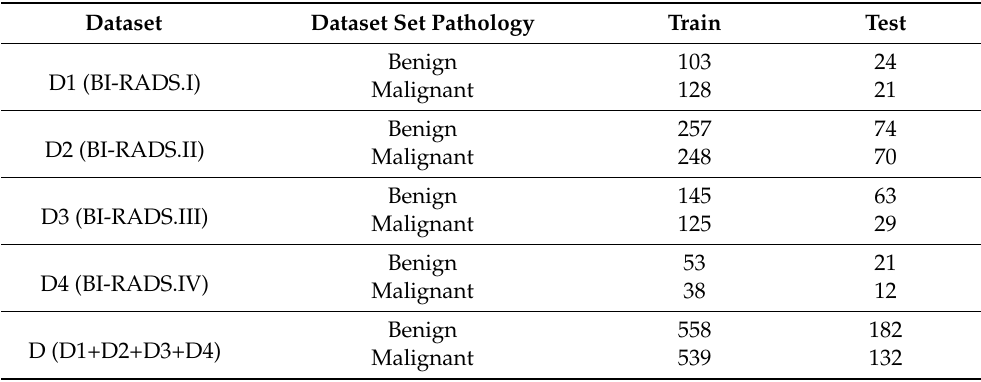
Table 2. Number of Curated Breast Imaging Subset of the Digital Database for Screening Mammog- raphy (CBIS-DDSM) mass ROI images.